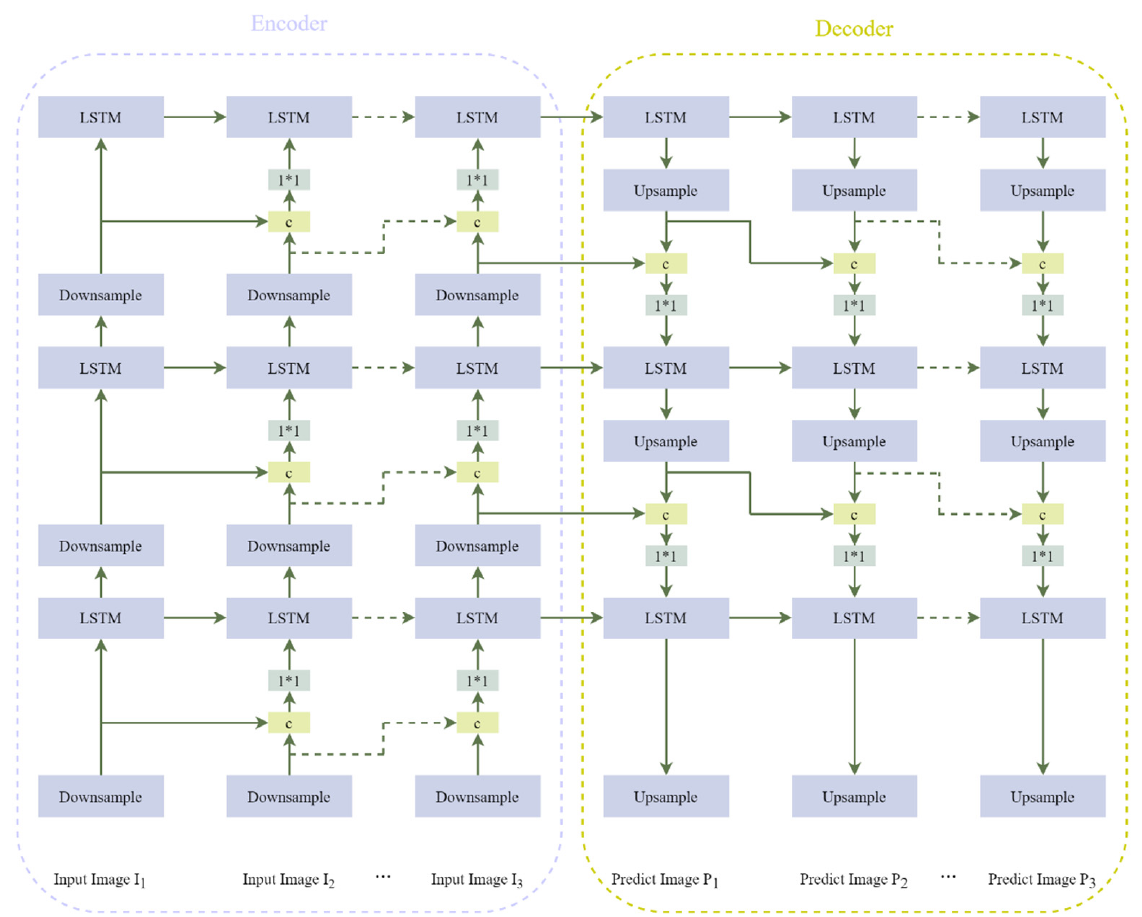
Figure 1. Architecture of the ConvLSTM network in the model.